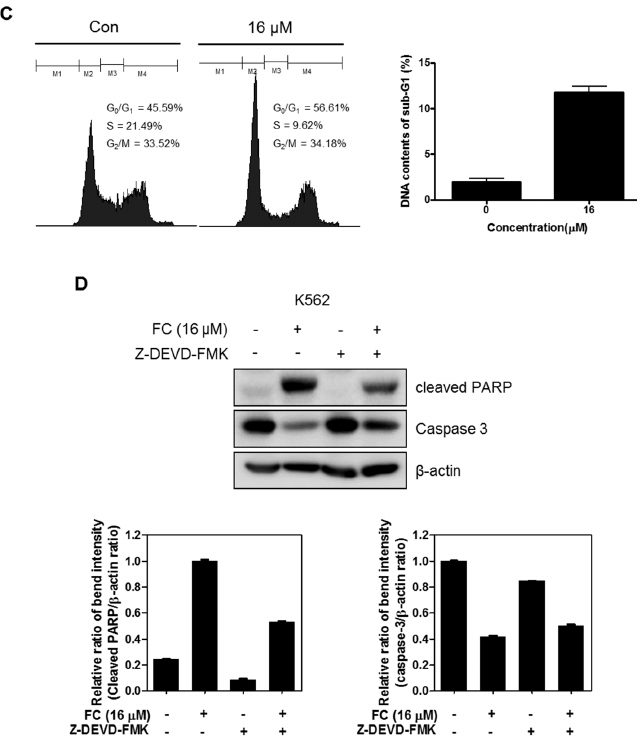
Figure 2. FC regulates apoptosis-related proteins and increases G1 arrest in K562 cells. ( A , B ) E ff ect of FC on procaspase9, cleaved caspase9, cleaved caspase3, PARP, and Bcl-2 in a concentration dependent fashion in K562 and KBM5 cells. ( C ) E ff ect of FC (16 µ M) on G1 arrest in K562 cells by Fluorescence-activated cell sorting (FACS) analysis. ( D ) E ff ect of caspase 3 inhibitor, Benzyloxycarbonyl-Asp(OMe)-Glu(OMe)-Val-Asp(OMe)-fluoromethylketone (Z-DEVD-FMK), on FC induced apoptosis in K562